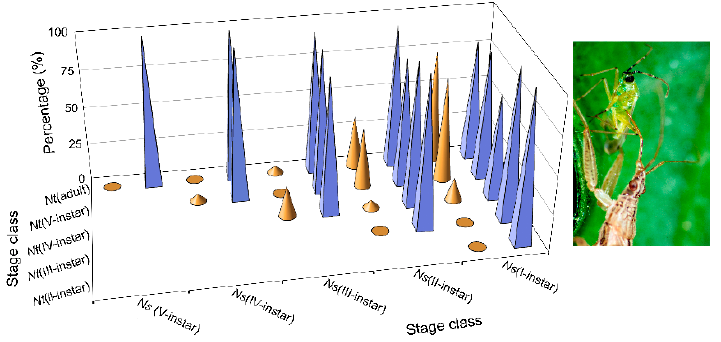
Figure 4. Stage-specific survival (%) of Nesidiocoris tenuis (brown cone, Nt) and Nabis pseudoferus (blue pyramid, Ns) in intraguild competition (IGP) when caged singly with the other species for 72 h under laboratory conditions (25 ± 1 °C and 60%–80% RH) without prey, and when N. pseudoferus was always in a lower stage class than N. tenuis .